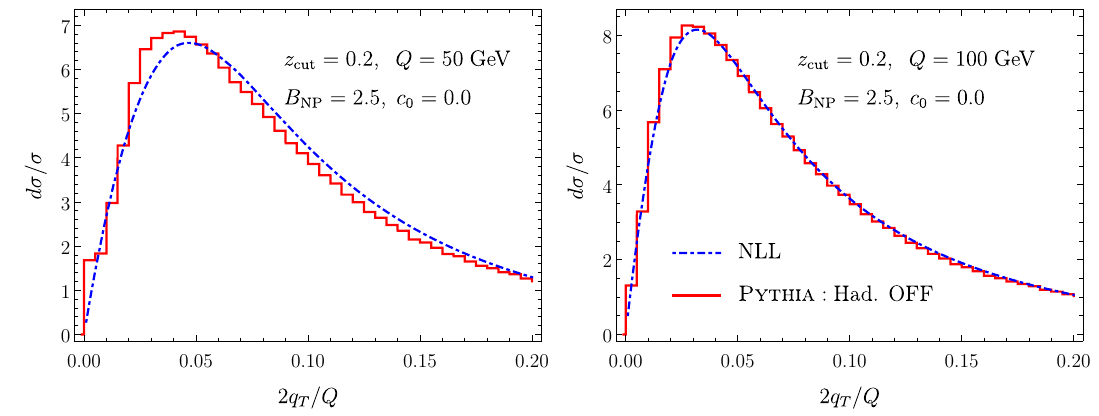
Figure 5 . Comparison of the NLL result against the partonic shower of Pythia 8 for R = 1 and e cut = 0 . 01 for two different center of mass energies, Left : 50 GeV, Right : 100 GeV.